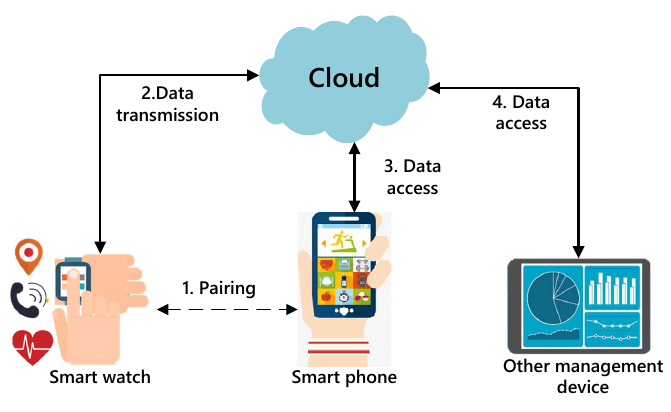
Figure 1. The sales of smart watches.